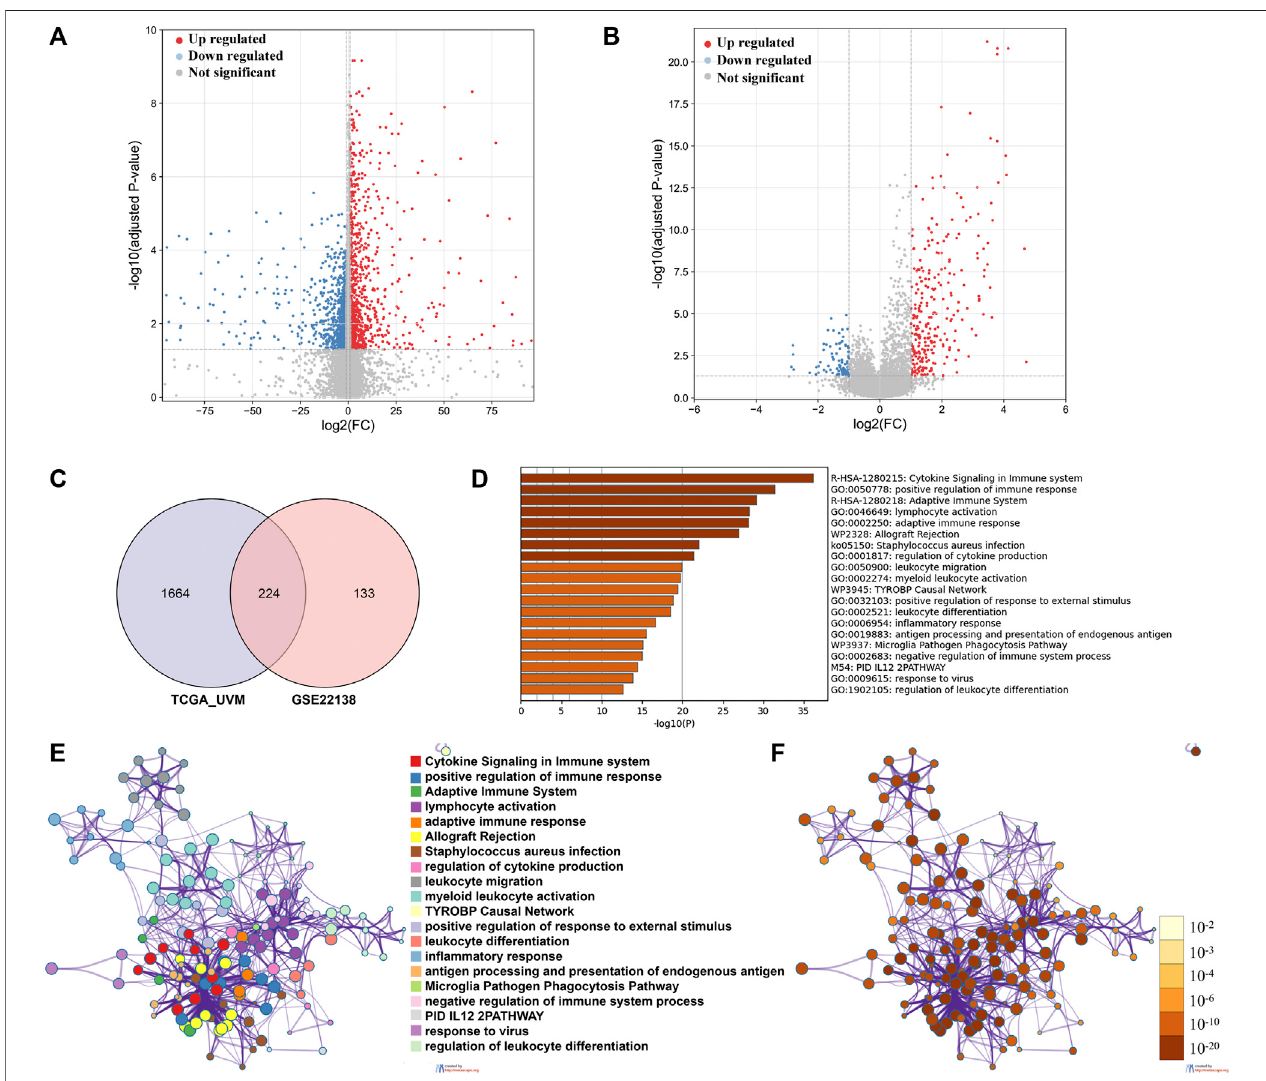
FIGURE 3 | Identi fi cation of DEGs and analysis of gene functional enrichment. (A,B) The volcano plot showed the DEGs between low and high immune cell in fi ltration groups in TCGA_UVM cohort (A) and in GSE22138 cohort (B) . (C) Venn Diagram showing 224 overlapped DEGs between TCGA_UVM and GSE22138 cohorts. (D) GO terms and pathways enriched in the 224 overlapped DEGs. (E) Network of enriched terms colored by cluster ID, where nodes that share the same cluster ID are typically close to each other. (F) Network of enriched terms colored by p-value, where terms containing more genes tend to have a more signi fi cant